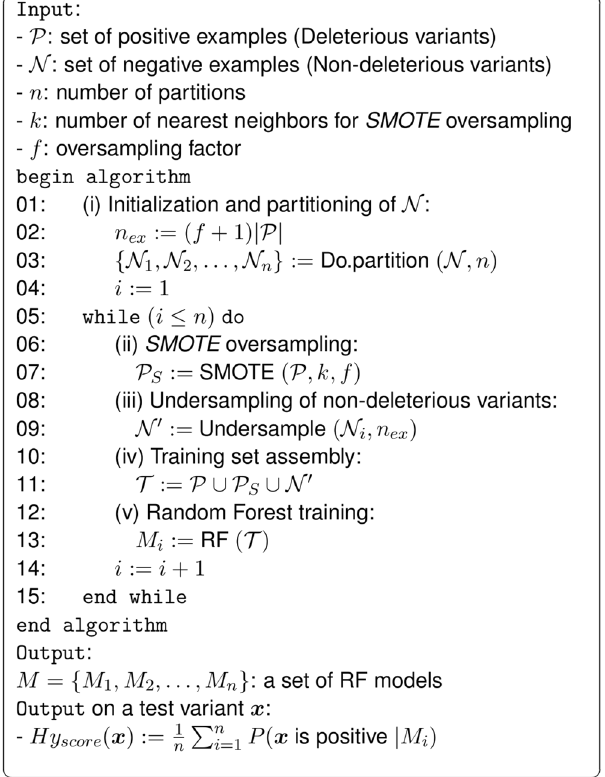
Figure 3. The hyperSMURF